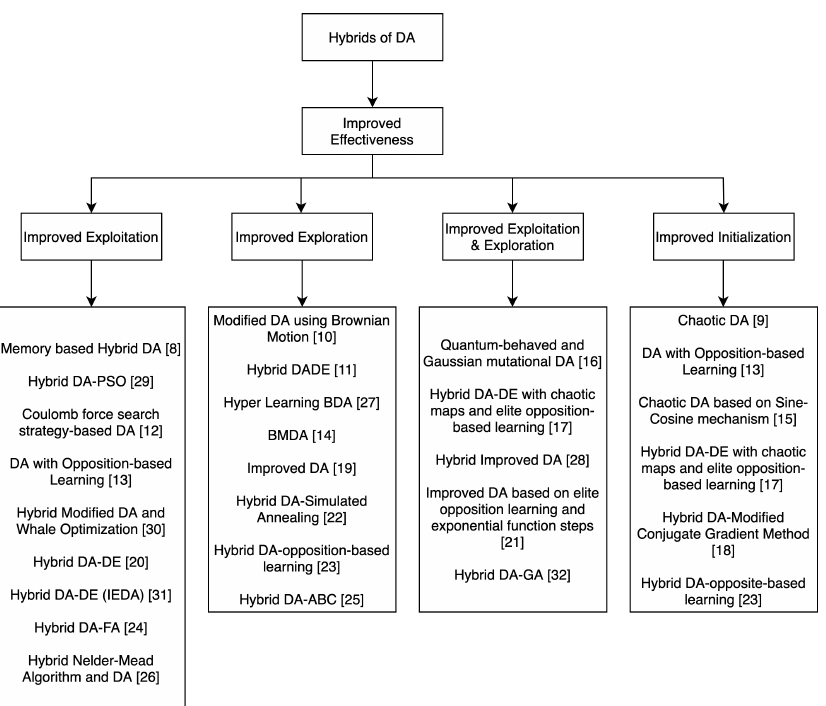
Figure 6. Taxonomy categorizing hybrids of DA in terms of effectiveness improving